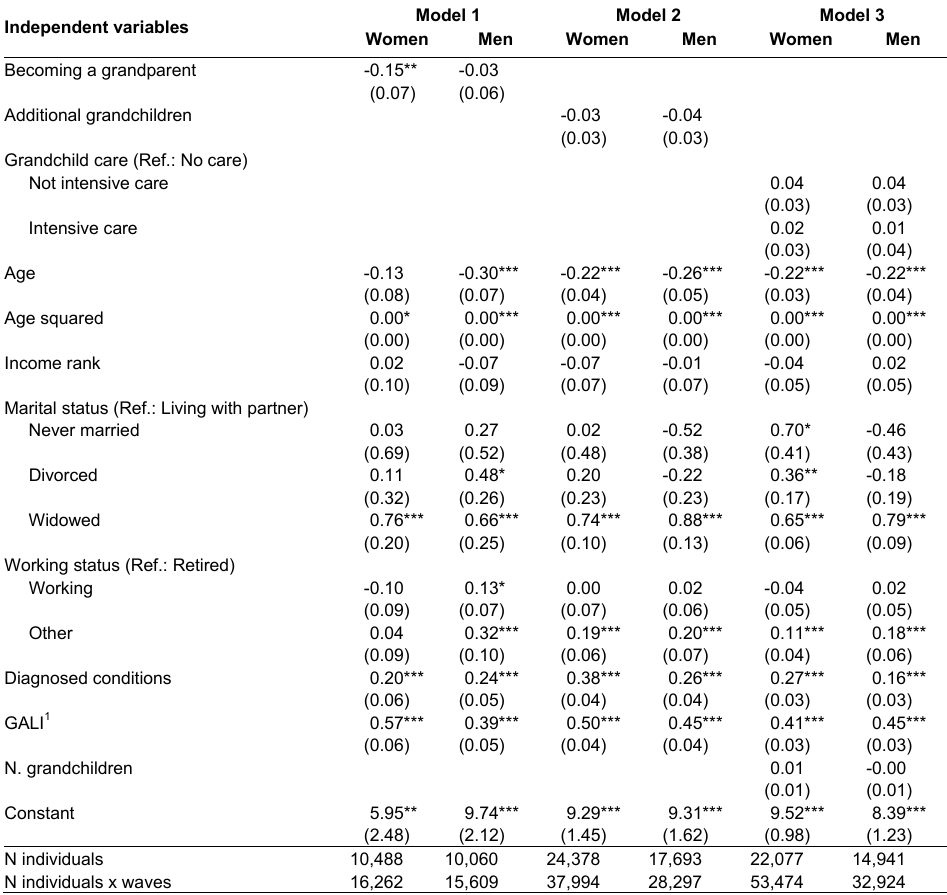
Fixed-effects models for the effect of becoming a grandparent (Model 1), having additional grandchildren (Model 2), and providing grandchild care (Model 3) on depressive symptoms, by